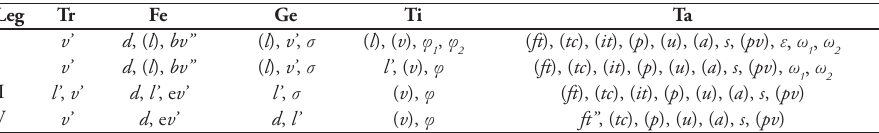
Table 1. Leg setation and solenidia of adult Basiceramerus ovatus sp. nov. Roman letters refer to normal setae, Greek letters to solenidia (except ɛ =famulus). Single prime (’) marks setae on the anterior and double prime (”) setae on the posterior side of a given leg segment. Parentheses refer to a pair of